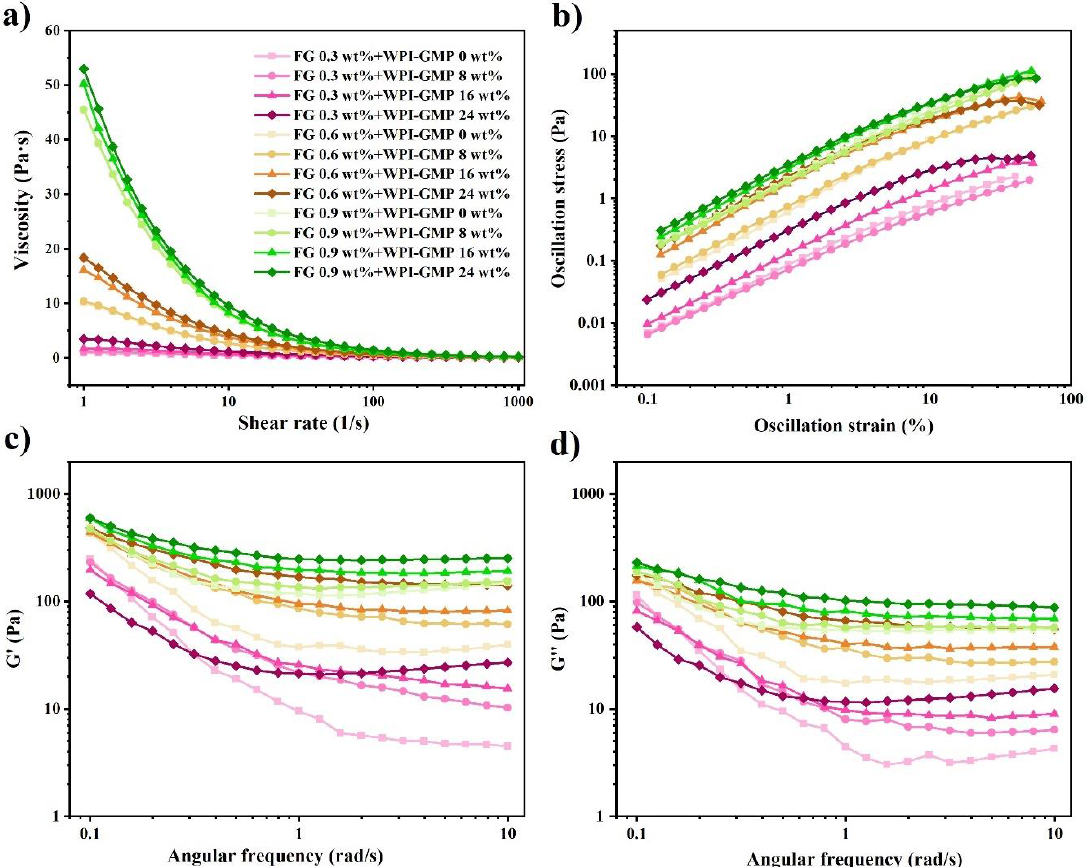
Figure 4. ( a ) Viscosity vs. shear rate flow curves of model mayonnaises, ( b ) strain amplitude sweep of model mayonnaises in the oscillatory shear test, ( c , d ) frequency sweep of model mayonnaises in the oscillatory shear test.